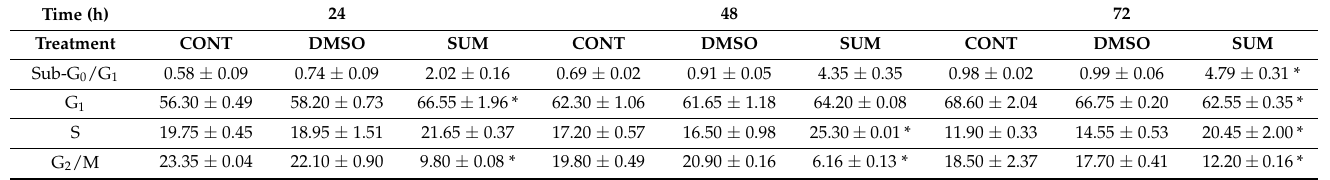
Table 4. The cell cycle distribution in MDA-MB-231 cells after sumac